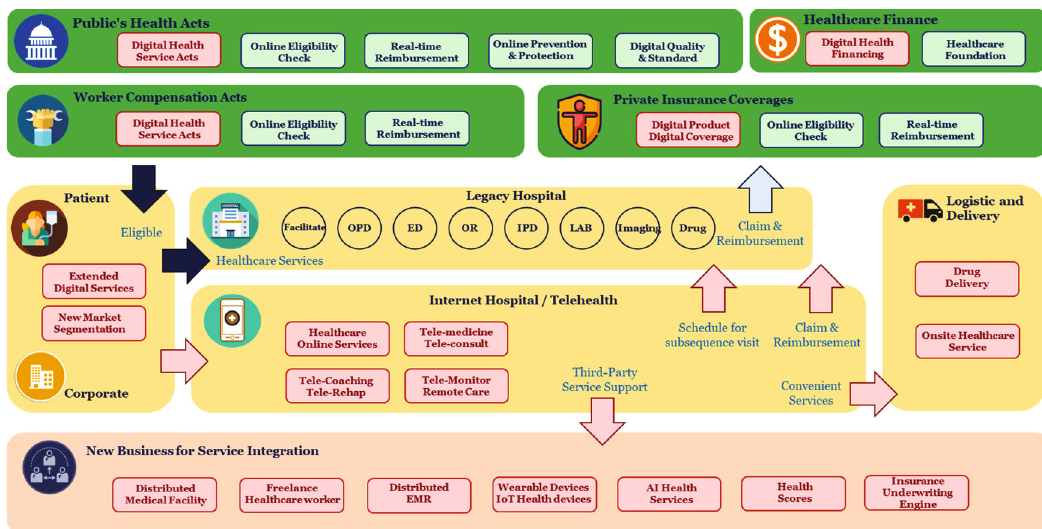
Figure 1: New era of digital healthcare